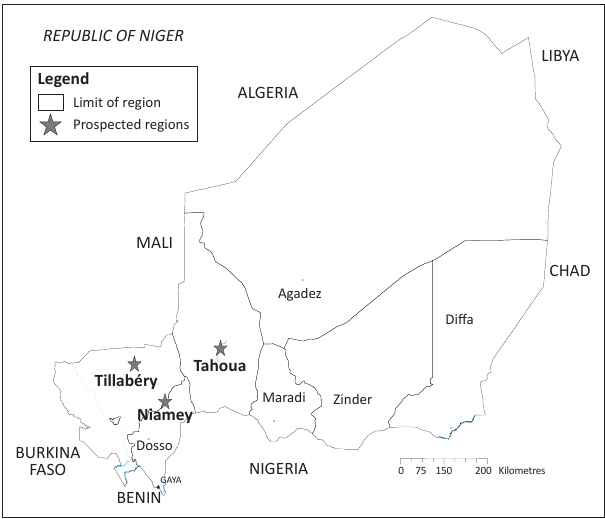
FIGURE 1: Location of farms surveyed in the Republic of Niger.